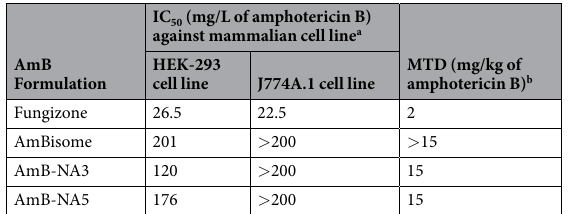
Table 2. In vitro and in vivo toxicity of amphotericin B formulations. a In vitro toxicity of different formulations of amphotericin B towards mammalian (J774A.1 and HEK-293) cell lines after 24 h of incubation (IC 50 ) using the MTT test. b In vivo toxicity (Maximum tolerated dose, MTD) of different formulations of amphotericin B in Balb/c female mice after a single bolus injection; values are calculated from the number of mice surviving the injection.